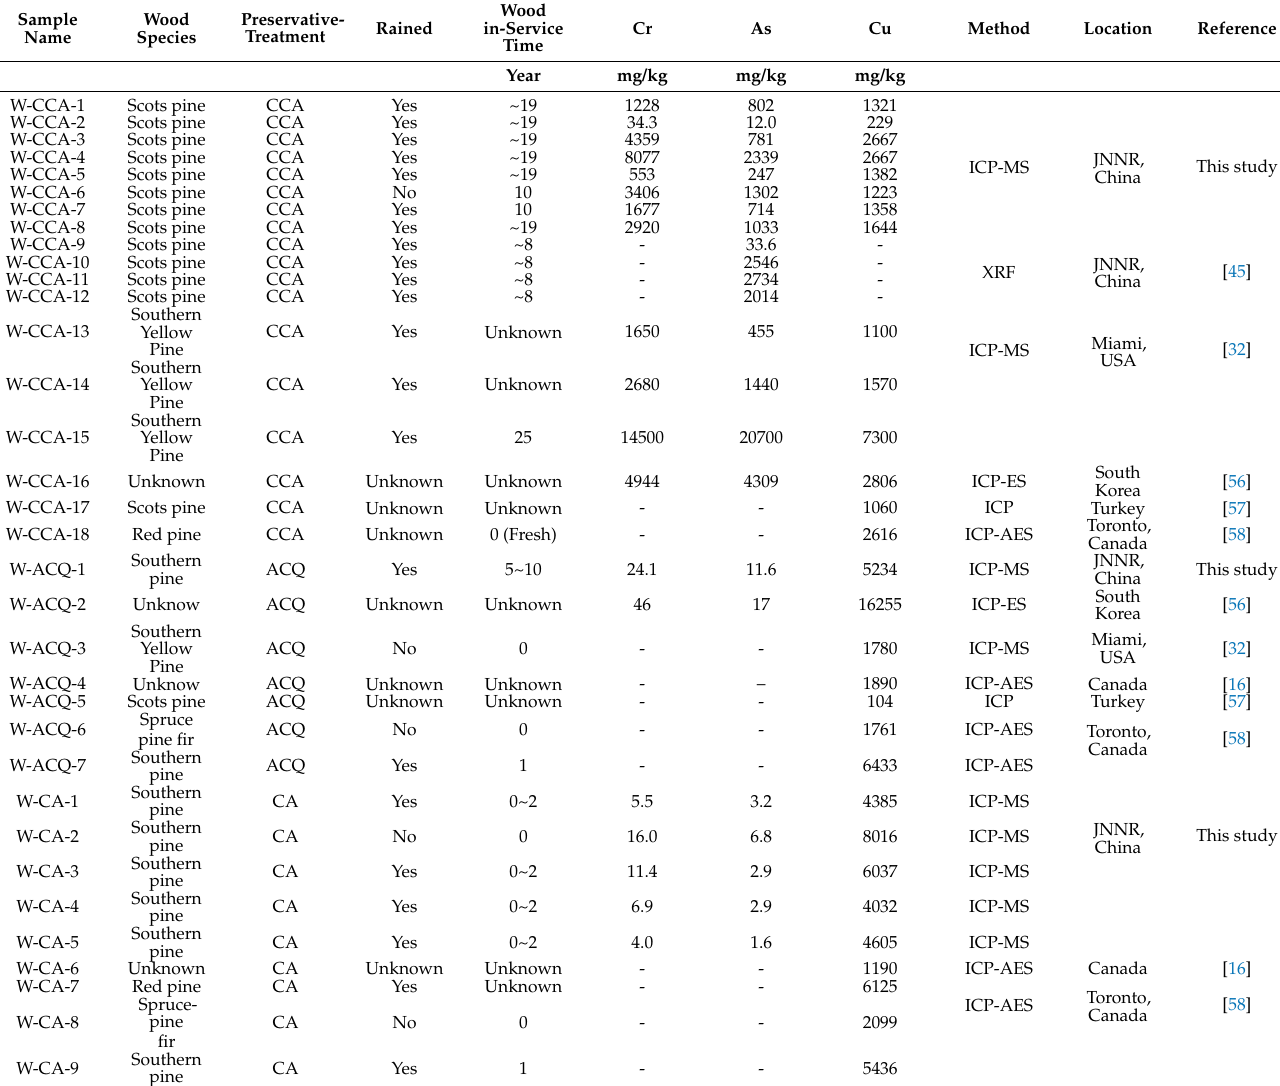
Table 2. Metal(loid) concentrations in the preservative-treated wood in the JNNR and other regions